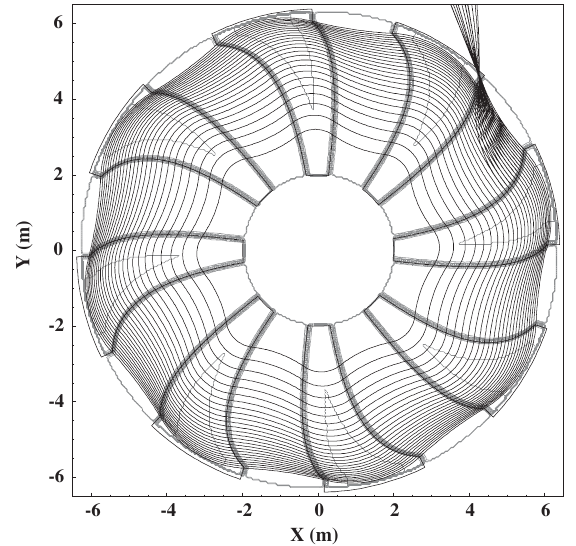
FIG. 7. Magnetic field contours, equilibrium orbits, and ex- traction trajectories of an eight-sector H þ 2 cyclotron for proton energies in the range between 500 and 950 MeV for ADS. The orbits of the protons after stripping are shown from 470 to 950